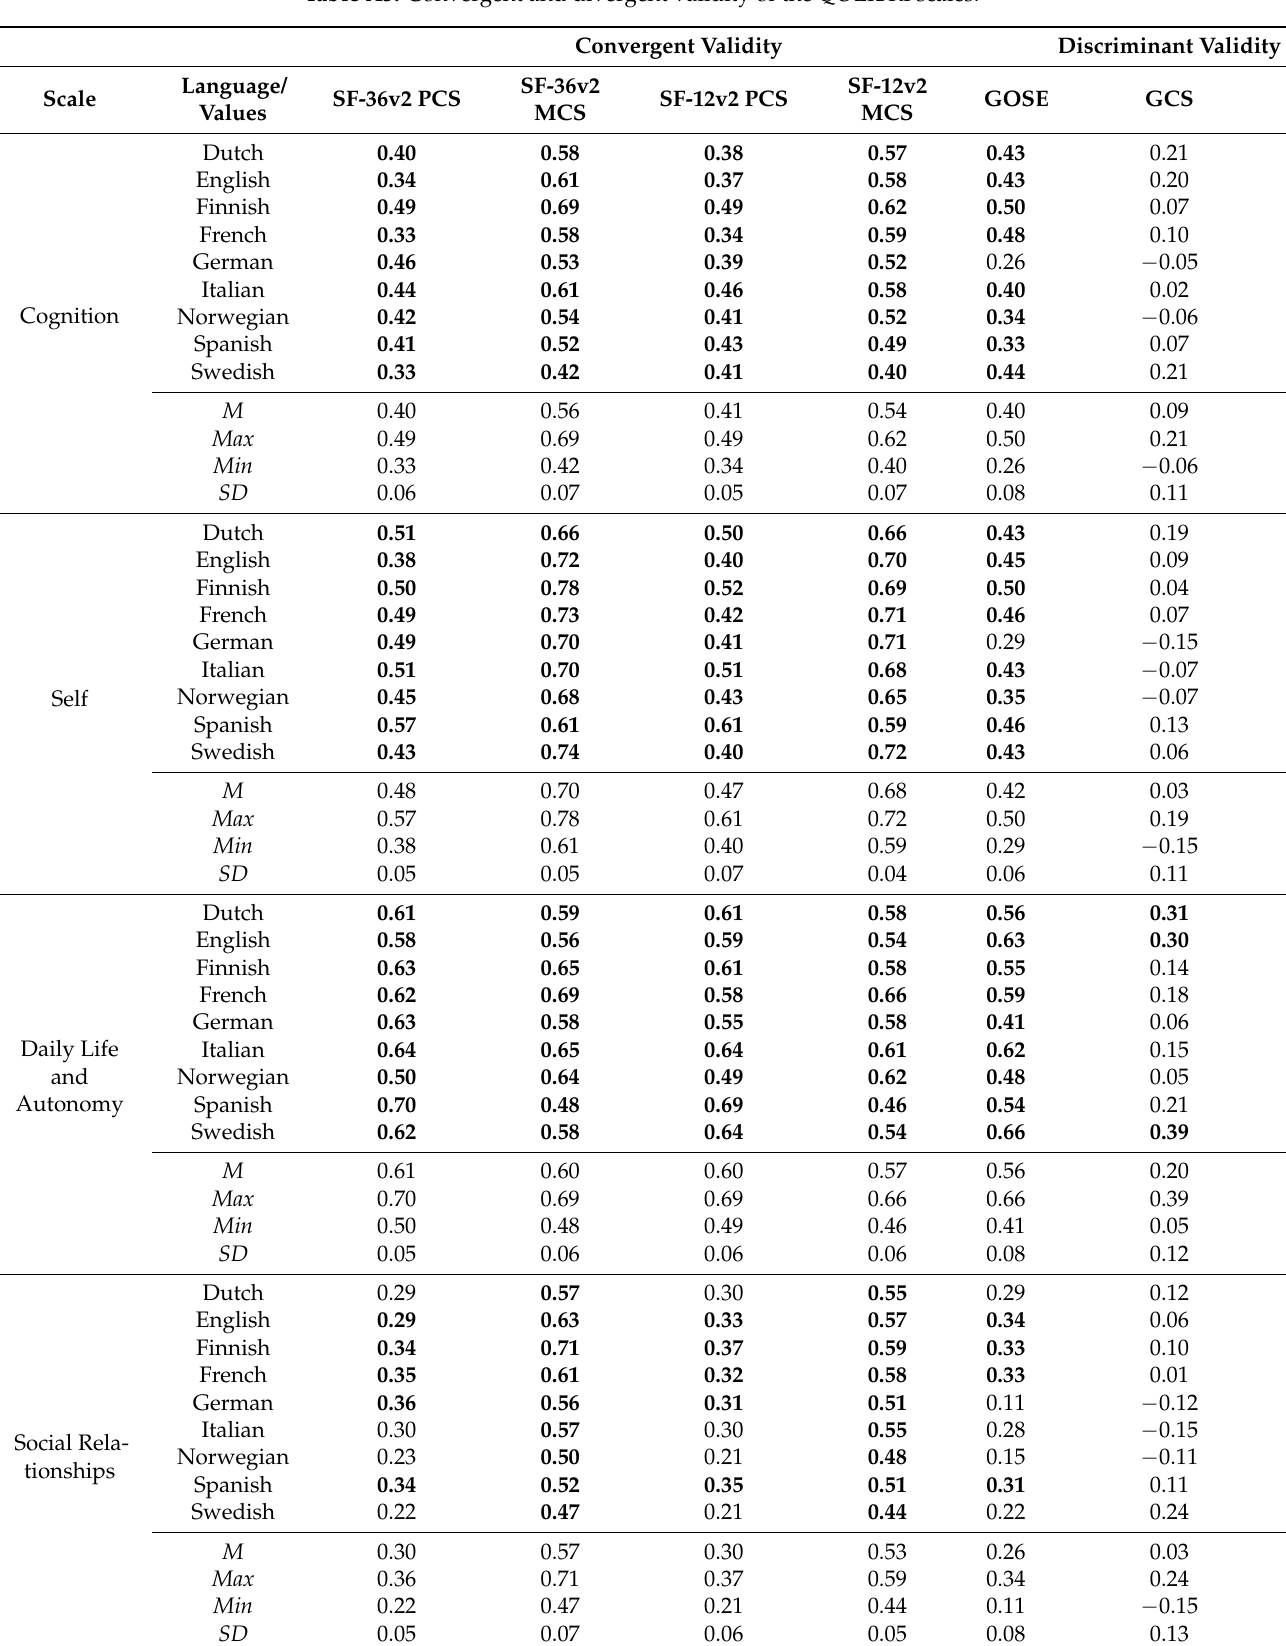
Table A3. Convergent and divergent validity of the QOLIBRI